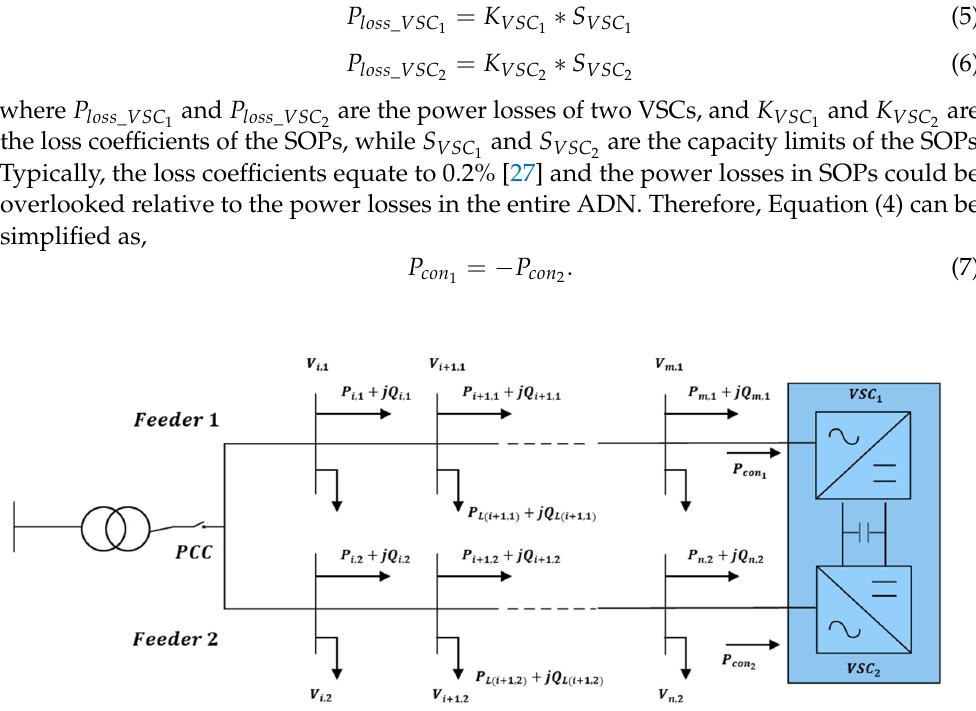
Figure 2. A simple active distribution network (ADN) with an SOP.